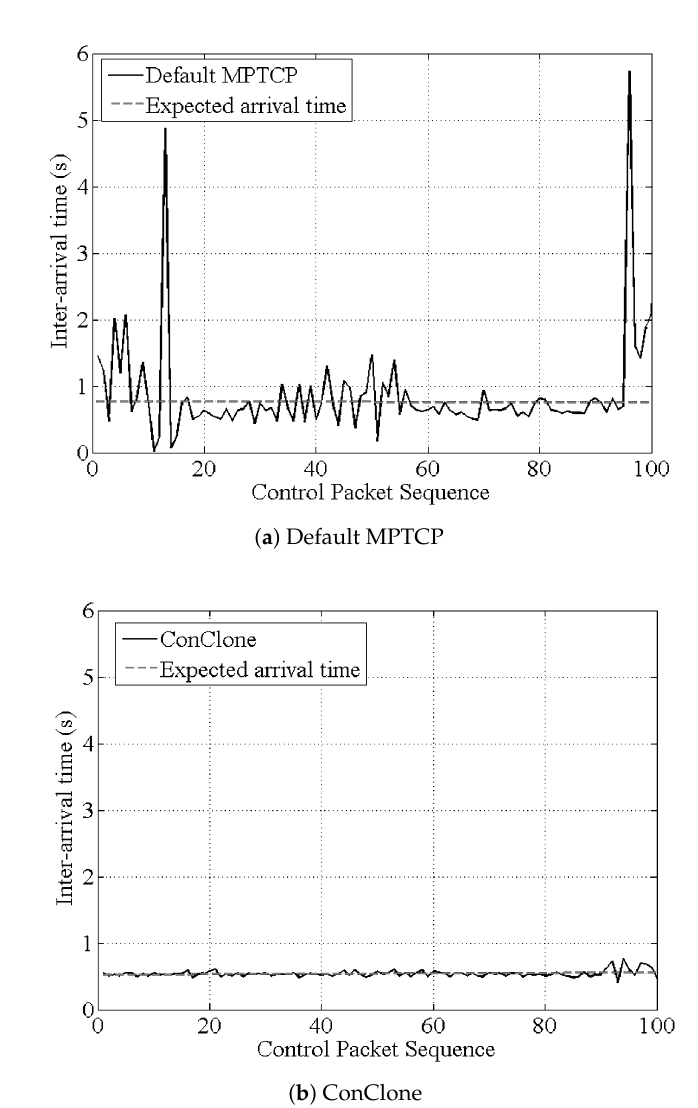
Figure 9. Comparison with expected inter-packet time.